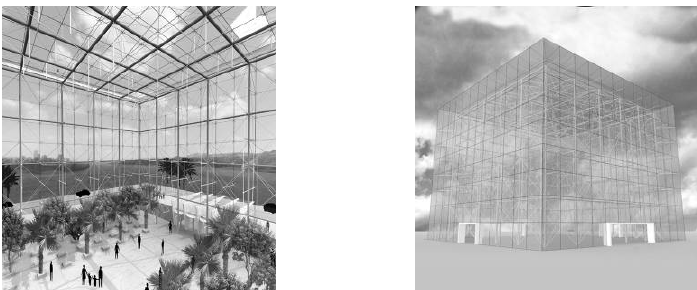
Figure 16 and 17: Design of the Glass Cube by architect Millanes and engineers Typsa and Octatube.